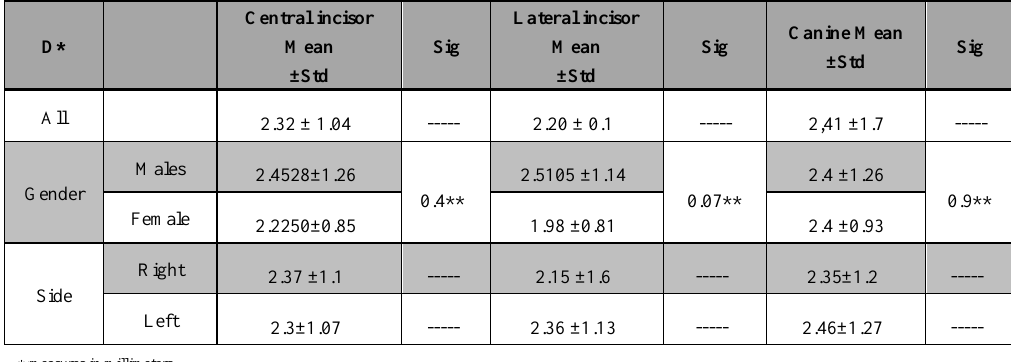
Table 4. Comparison of the means facial bone crest(mm) of anterior teeth according to the side and gender.